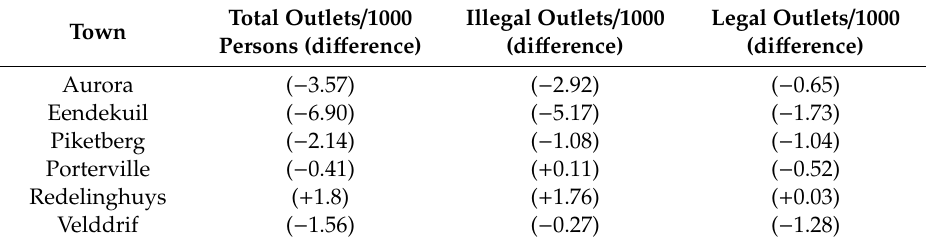
Table 3. Di ff erence in outlets / 1000 persons between two datasets.